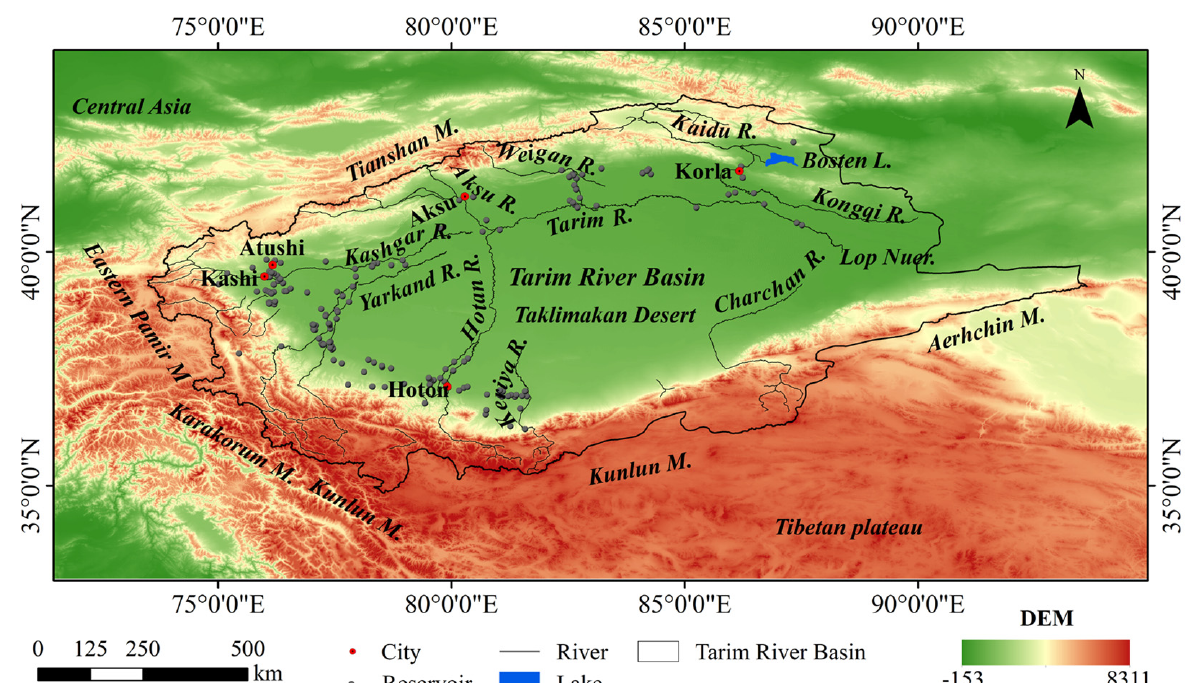
Figure 1. Description of the study area.